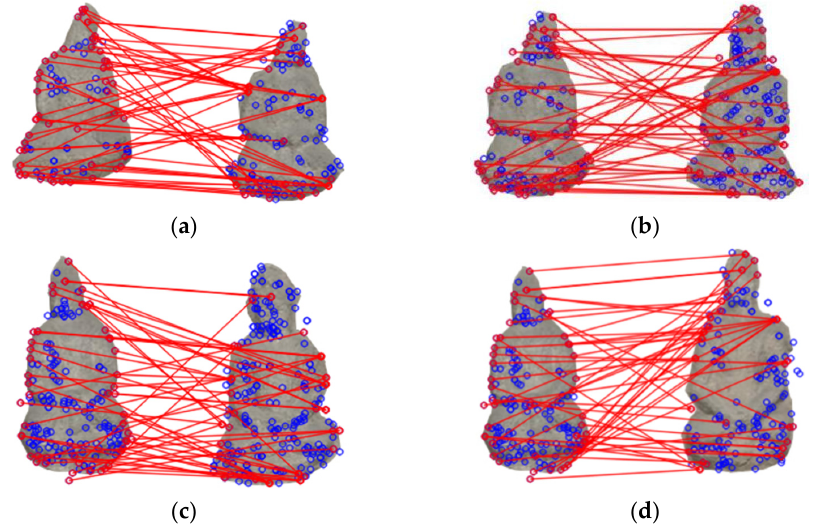
Figure 11. Extracting detail feature points of similar Buddhist statues using the SIFT algorithm. ( a ) Feature point matching of Buddhist Image No. 1 and Buddhist Image No. 2; ( b ) Feature point matching of Buddhist Image No. 2 and Buddhist Image No. 3; ( c ) Feature point matching of Buddhist Image No. 4 and Buddhist Image No. 9; ( d ) Feature point matching of Buddhist Image No. 4 and Buddhist Image No. 10.